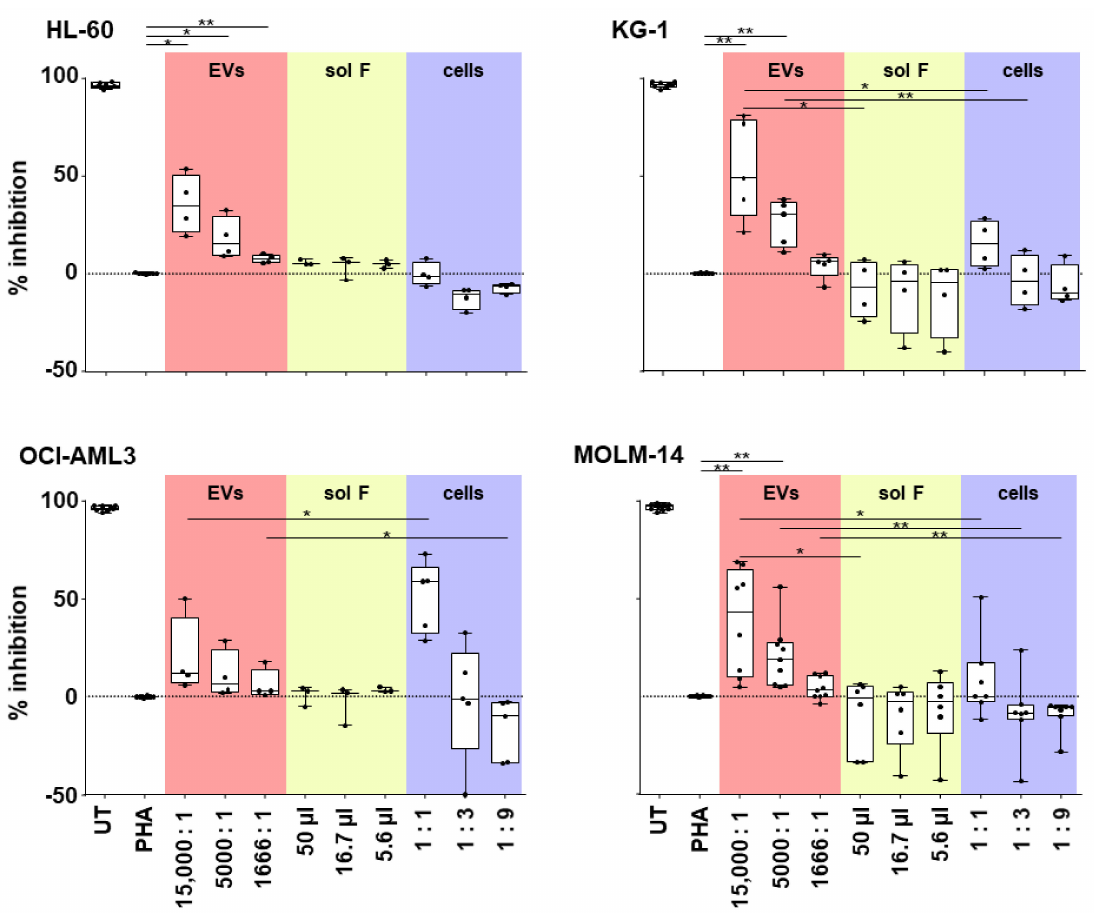
Figure 4. EVs derived from AML cells suppress T-cell proliferation. Purified AML derived EVs (red fields) were compared to the EV-producing cells (blue fields) and the EV-depleted soluble factors (sol F; yellow fields) for their capacity to